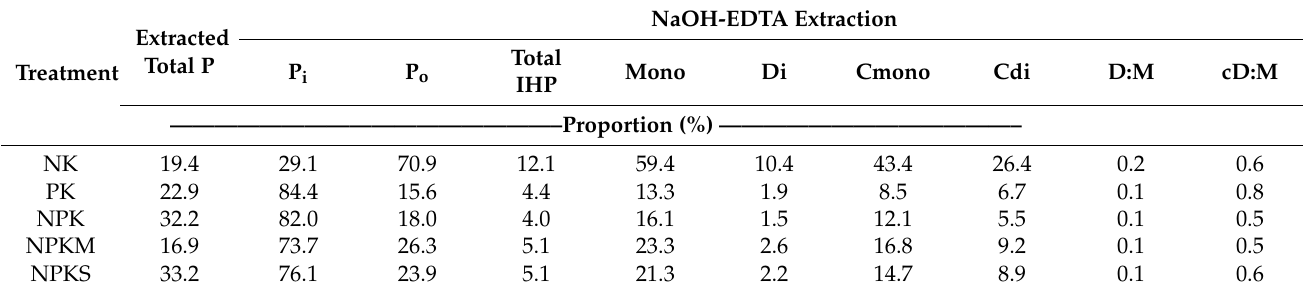
Table 4. Phosphorus form classes or ratios of form classes in NaOH-EDTA extractions of the studied soils in 2015 determined by P-NMR